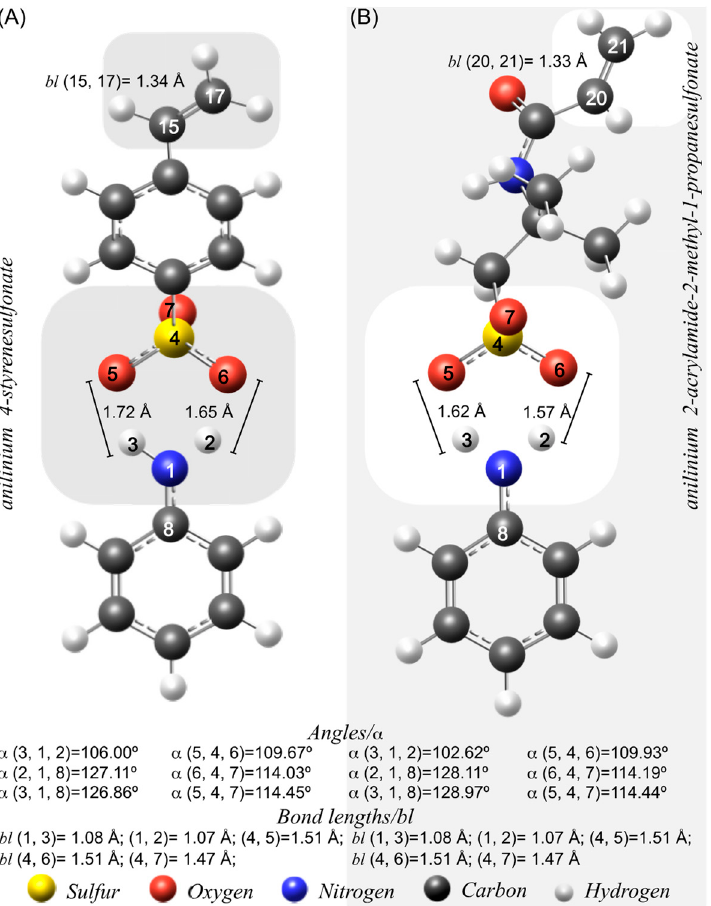
Figure 1. Bond angles and bond lengths of molecular models of ( A ) anilinium 4-styrenesulfonate (ani-SS) and ( B ) anilinium 2-acrylamide-2-methyl-1-propanesulfonate (ani-AMPS).